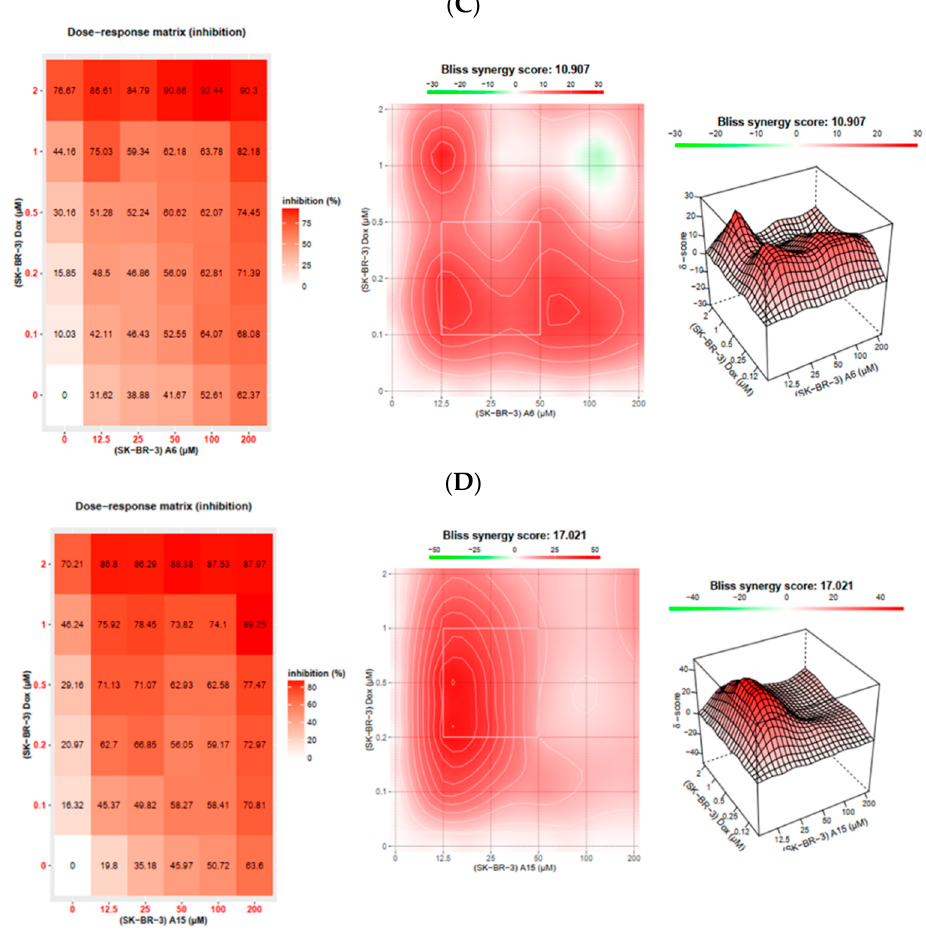
Figure 12. Dose − response matrix inhibition for the combination treatment of doxorubicin (DOX) with A6 or A15 on MCF-7 and SK-BR-3 cells and their 2D and 3D synergy maps. ( A , B ) DOX and ( A ) A6 or ( B ) A15 on MCF-7 cells; ( C , D ) DOX and ( C ) A6 or ( D ) A15 on SK-BR-3 cells. Synergy maps are highlighted in red and green colors for the synergistic and antagonistic regions, respectively. Bliss independence method was applied to calculate the expected responses of the combination treatment using SynergyFinder 2.0 software, as described in the Materials and Methods.